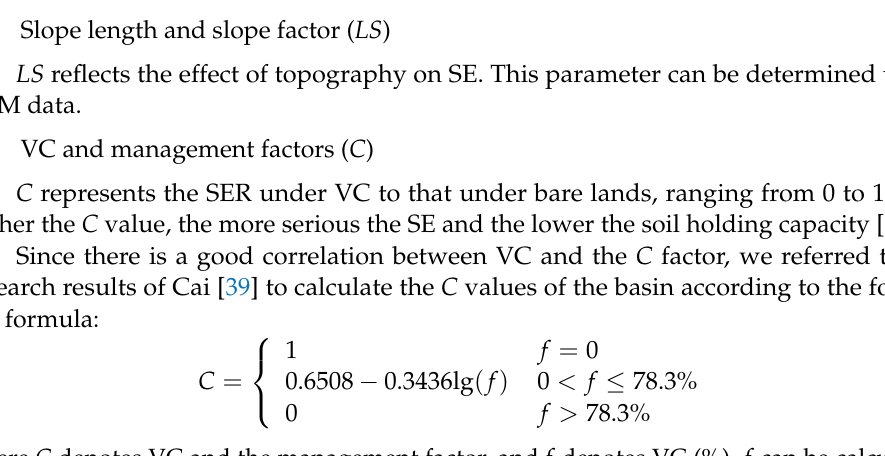
Figure 4. Distribution map of K values in the QLB.